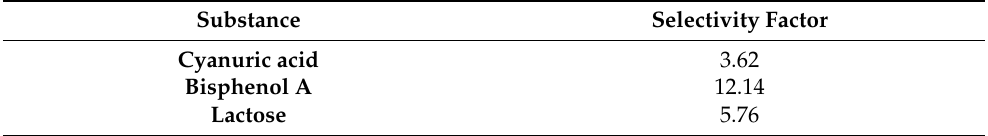
Table 2. Selectivity factors of the developed thermal platform.